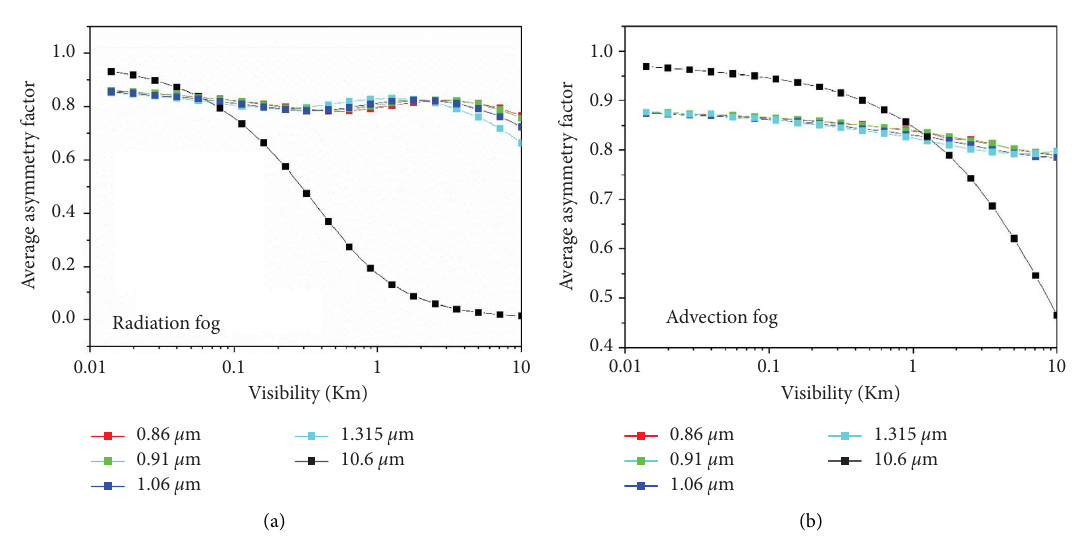
Figure 4: Average asymmetry factor versus